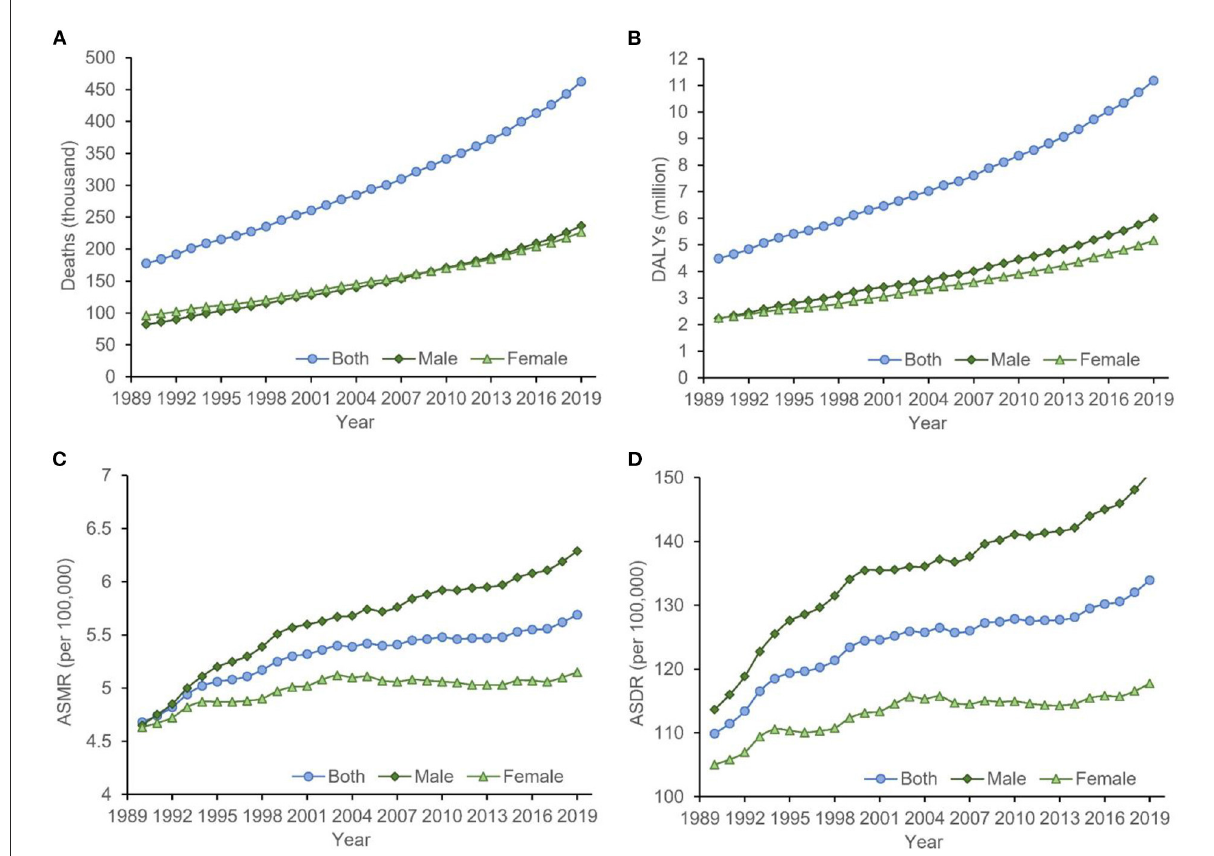
FIGURE1 The temporal trends of the (A) deaths, (B) DALYs, (C) ASMR, and (D) ASDR for cancer attributable to high BMI from 1990 to 2019. The burden of cancer attributable to high BMI had been increasing significantly in both sexes, which was more obvious for men. ASDR, age-standardized DALYs rate; ASMR, age-standardized mortality rate; BMI, body mass index; DALYs, disability-adjusted